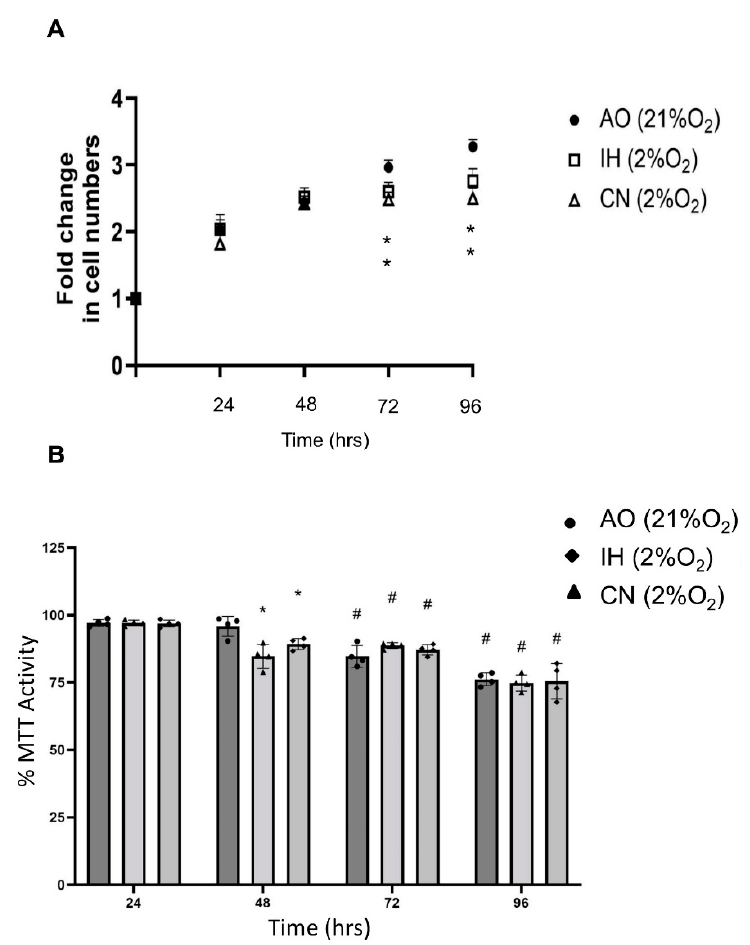
Figure 1. PC12 cell proliferation and MTT activities in different oxygen conditions. ( A ) Fold change in cell counts of PC12 cells under air oxygen (AO), intermittent hypoxia (IH) or continuous normoxia (CN) across a 96 h time-course. Cell proliferation was significantly reduced after 72 and 96 h incubation in both IH and CH. X-axis indicates time (h). Y-axis indicates fold changes in cell numbers. ( B ) MTT activity of PC12 cells in AO, IH or CH across a 96 h time-course. MTT activities were significantly reduced in both IH and CH compared to in AO at 48 h; however, there were no significant differences at other time points. In addition, the MTT activity values at 72 and 96 h were significantly lower than those at 24 h. X-axis indicates time (h). Y-axis indicates Abs. value normalised to Abs. of control at each time point. Data are expressed as mean + S.E.M., n = 4. Statistical significance of the assay was evaluated using one-way ANOVA with Tukey post hoc corrections; * indicates significant change in comparison to the AO control at each time point ( p < 0.05). # indicates significant change in comparison to corresponding values recorded on day 1 ( p < 0.05).